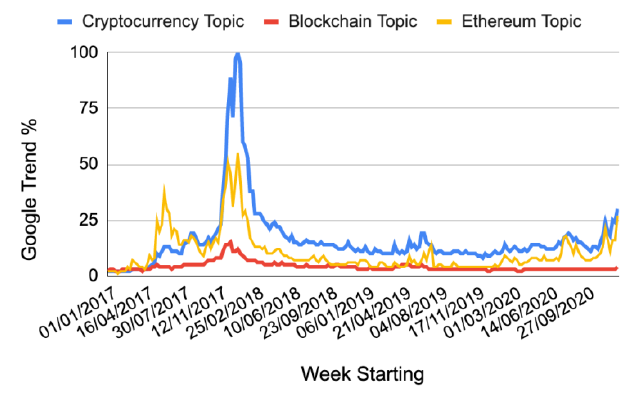
Figure 13: Google topic trend results for ‘Cryptocurrency’, ‘Blockchain’ and 'Ethereum’.